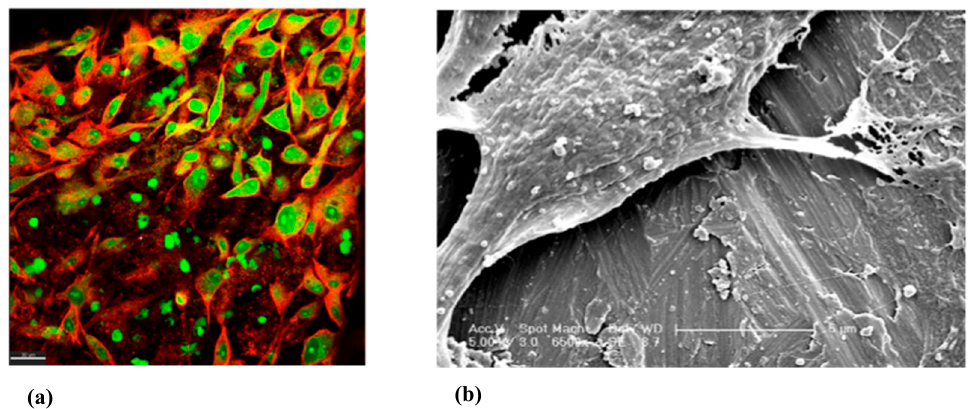
Figure 7. ( a ) Composite xy view CLSM image of MG-63 cells showing nucleus in green and actin filaments of the cytoskeleton in red grown on top of a disinfected M surface T2A+ group (scale bar = 30 µm). ( b ) SEM image of M surface T2A (scale bar = 5 µm, magnification 6500×).